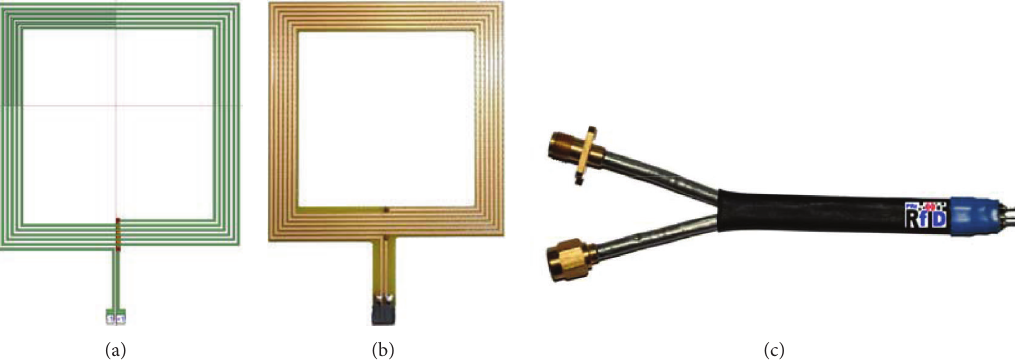
Figure 5: Transponder antenna: (a) HyperLynx 3D EM winding model, (b) test antenna, and (c) differential probe.